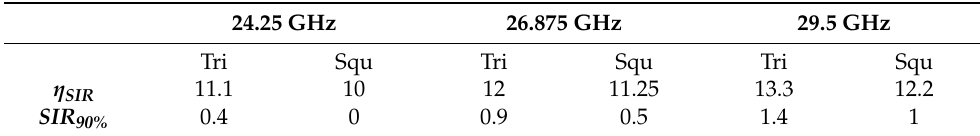
Figure 18. ( a ) SE comparison as a function of the number of users ( K ) between square and triangu- lar lattice planar arrays composed of 64 elements; and ( b ) percentage SE improvement in the event of  = 20 dB.